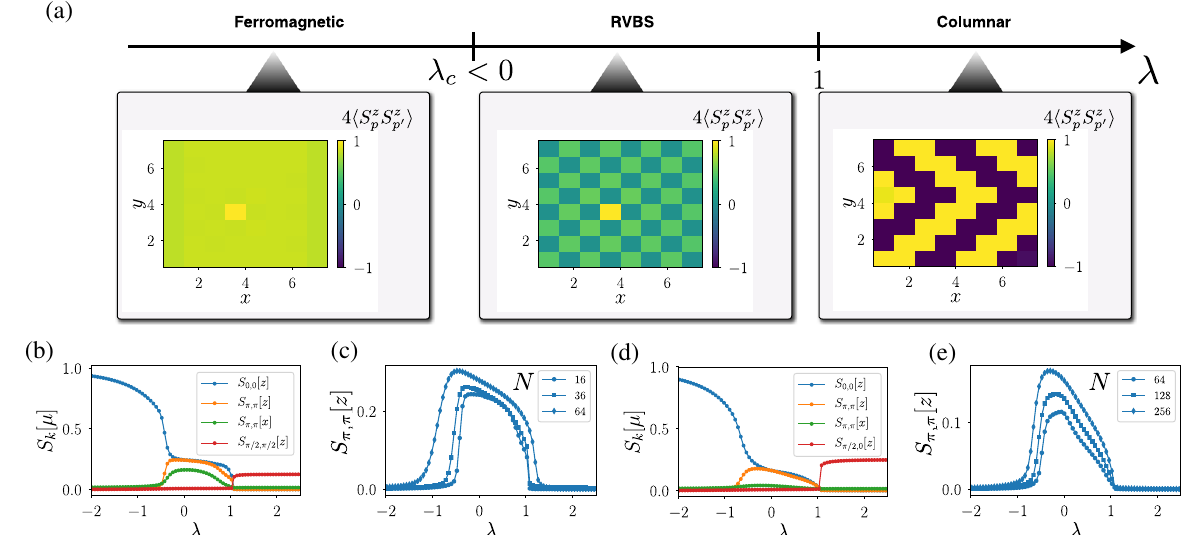
FIG. 3. Dual RK model and its phases. (a) Phase diagram of the 2D RK model on the square lattice without background charges. In the boxes, we plot the spin-spin correlations h S μ p S μ i obtained via DMRG [87] on square lattices N x × N y ¼ 8 × 8 and for three values p 0 of λ ¼ − 1 , 0, 2 that belong to the ferromagnetic (N´eel), RVBS, and columnar phases, respectively. The correlations are represented with respect to the center, p ¼ ð 4 ; 4 Þ , for varying p 0 . Note that in the λ → ∞ limit there are multiple degenerate unflippable states. The particular configuration shown here in the right panel corresponds to one of them. (b),(c) Structure factors S P ˆ ˆ 2 4 = ð N S μ N S μ exp ½ i ð p − p 0 Þ k (cid:2)h i , μ ¼ x , z for N x × N y ¼ 8 × 8 [(b)] and for different system sizes N ¼ N x N y ¼ N 2 x [(c)]. p x y Þ p;p 0 p 0 The raising of the structure factors S ½ x; z (cid:2) identifies the RVBS phase. In particular, S ð π ; π Þ (d),(e) Structure factors on the periodic ladder of N × 2 sizes, without background charges, with N x 64, 128